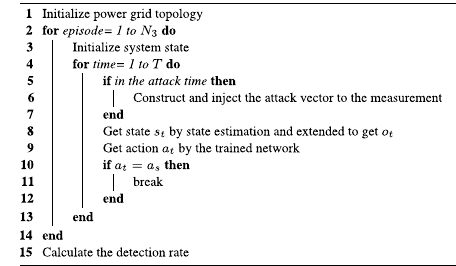
Algorithm 2. Training of the a optimized DQN-based FDIA detection algorithm.